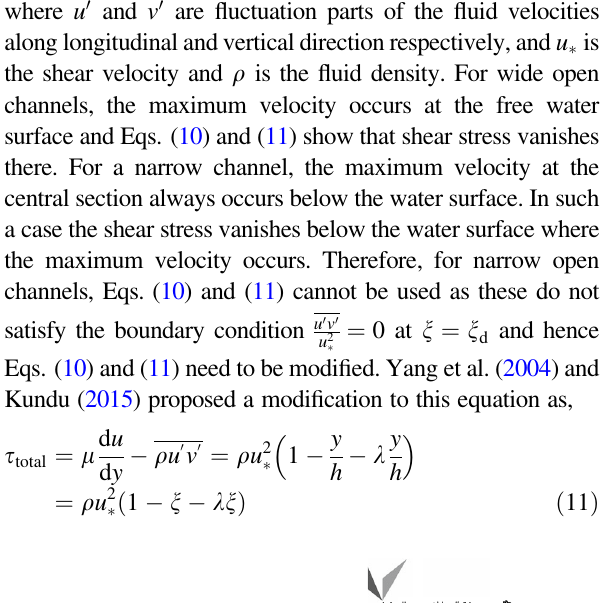
where u 0 and v 0 are fluctuation parts of the fluid velocities